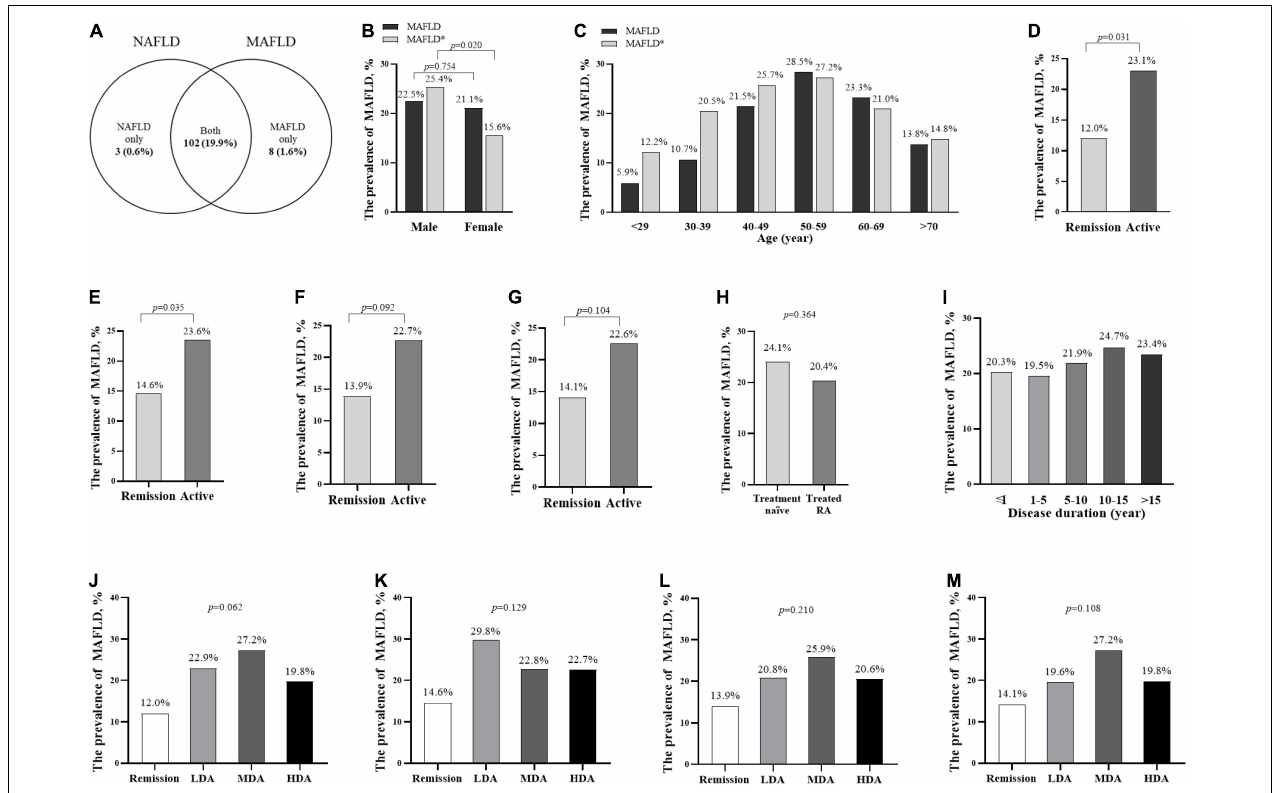
FIGURE 1 | The prevalence of MAFLD in patients with RA with different stratification. The prevalence of MAFLD and NAFLD in all patients with RA (A) the prevalence and standardized prevalence in different genders (B) and age groups (C) ; the prevalence in different disease activity groups according to CDAI (D,J) , DAS28-CRP (E,K) , SDAI (F,L) , DAS28-ESR (G,M) , treatment groups (H) , and disease duration groups (I) . ∗ The standardized prevalence of MAFLD was adjusted the age or sex composition ratio according to the data in the 2020 China Statistical Yearbook. (cid:49) Treatment naïve, without previous corticosteroids or DMARDs treatment